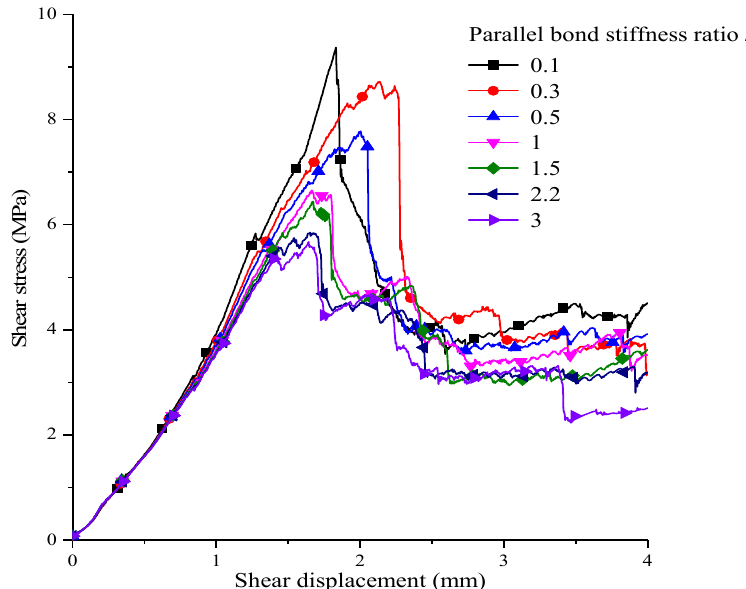
Figure 7. Shear stress–shear displacement curves of corresponding different parallel bond stiffness ratios.